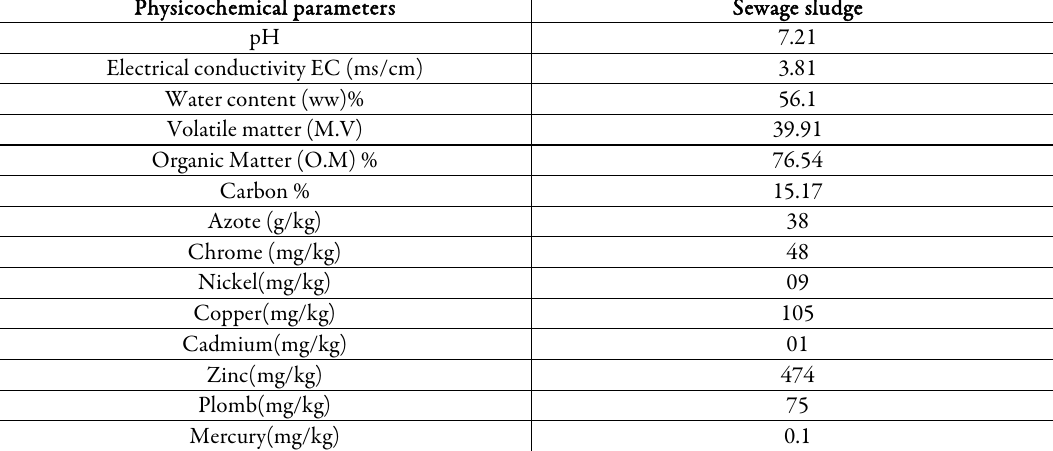
Table 2. Physicochemical parameters of sewage sludge used in the experiment